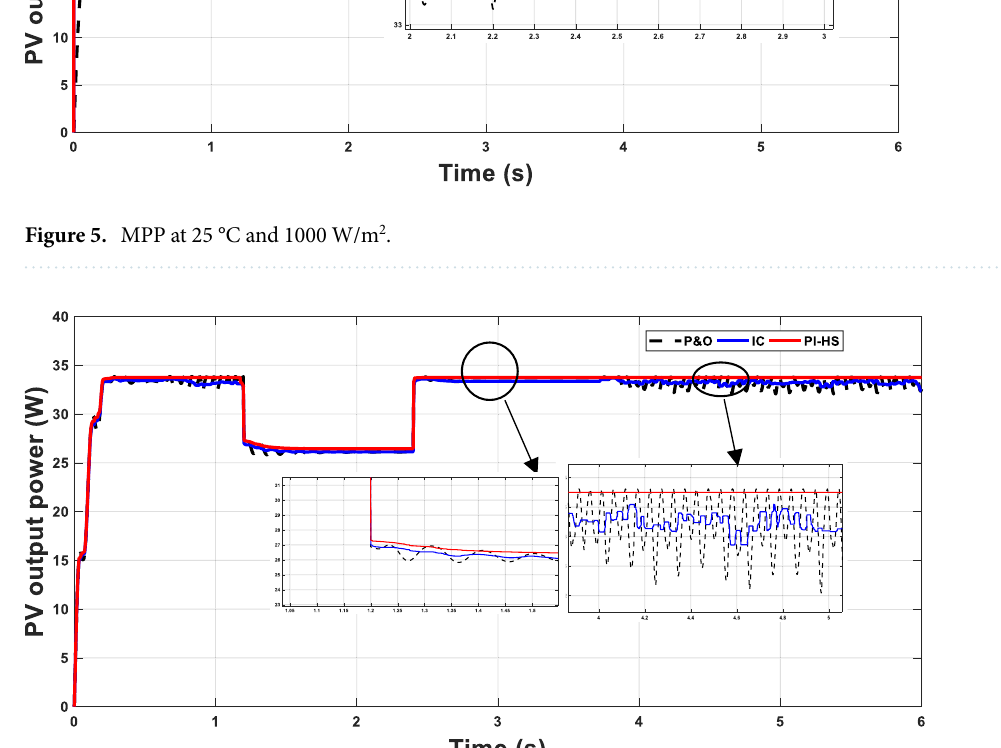
Figure 6. MPP with change from point 30 to point 22, defined in Table